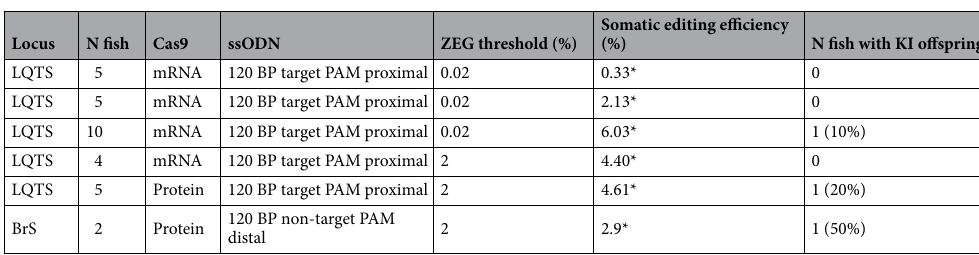
Table 3. Germline transmission of the knock-in allele at the cacna1c LQTS and BrS loci in selected embryos. N number, ssODN single-stranded deoxynucleotide, ZEG zebrafish embryo genotyper, KI knock-in, BP base pair. *Established from ZEG in embryos selected for raising to